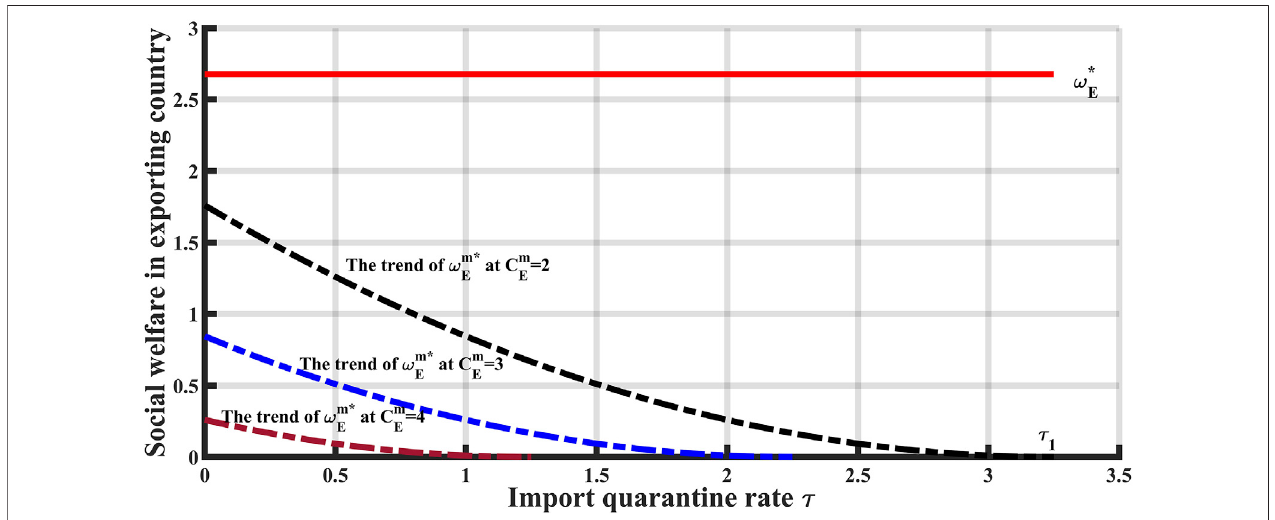
FIGURE 1 | Trend of social welfare changes in exporting country. (Source: Simulation data for numerical